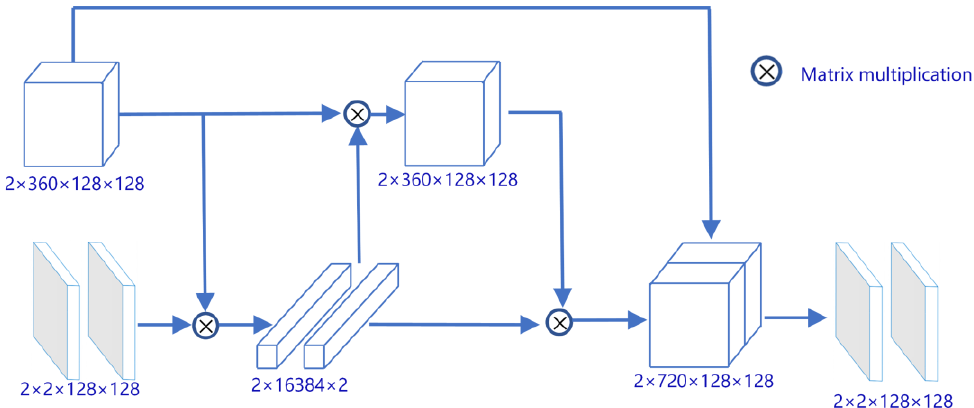
Figure 6. OCR refine module.